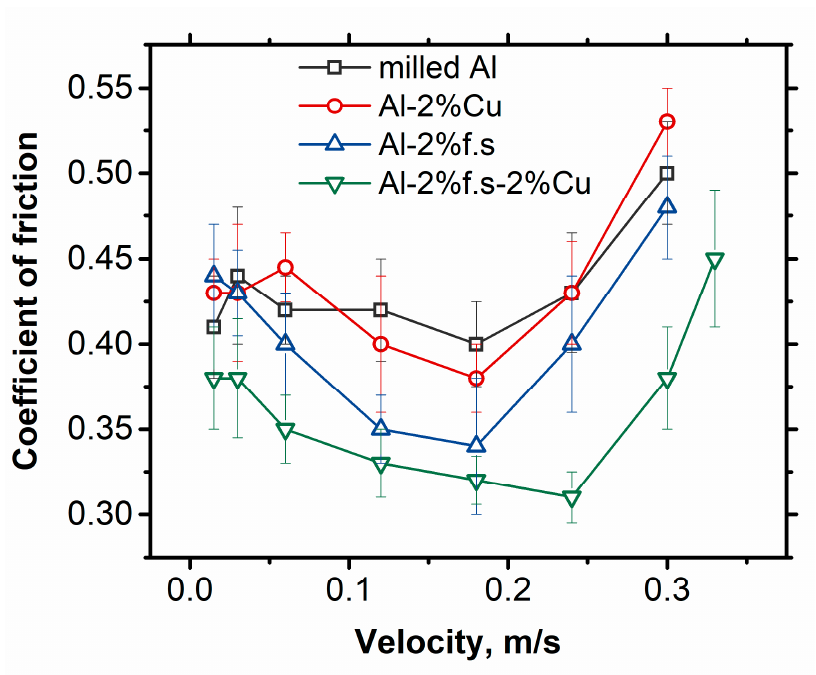
Figure 5. The dependence of the friction coefficient on rotation speed at a load of 20 N (0.13 MPa).